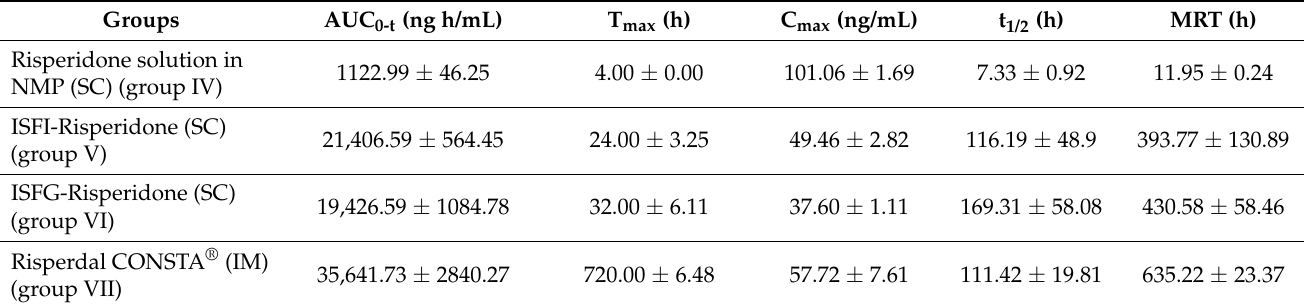
Table 2. Pharmacokinetic parameters resulting from the administration of formulations containing 25 mg of risperidone to rabbits (n = 3) using PK solver